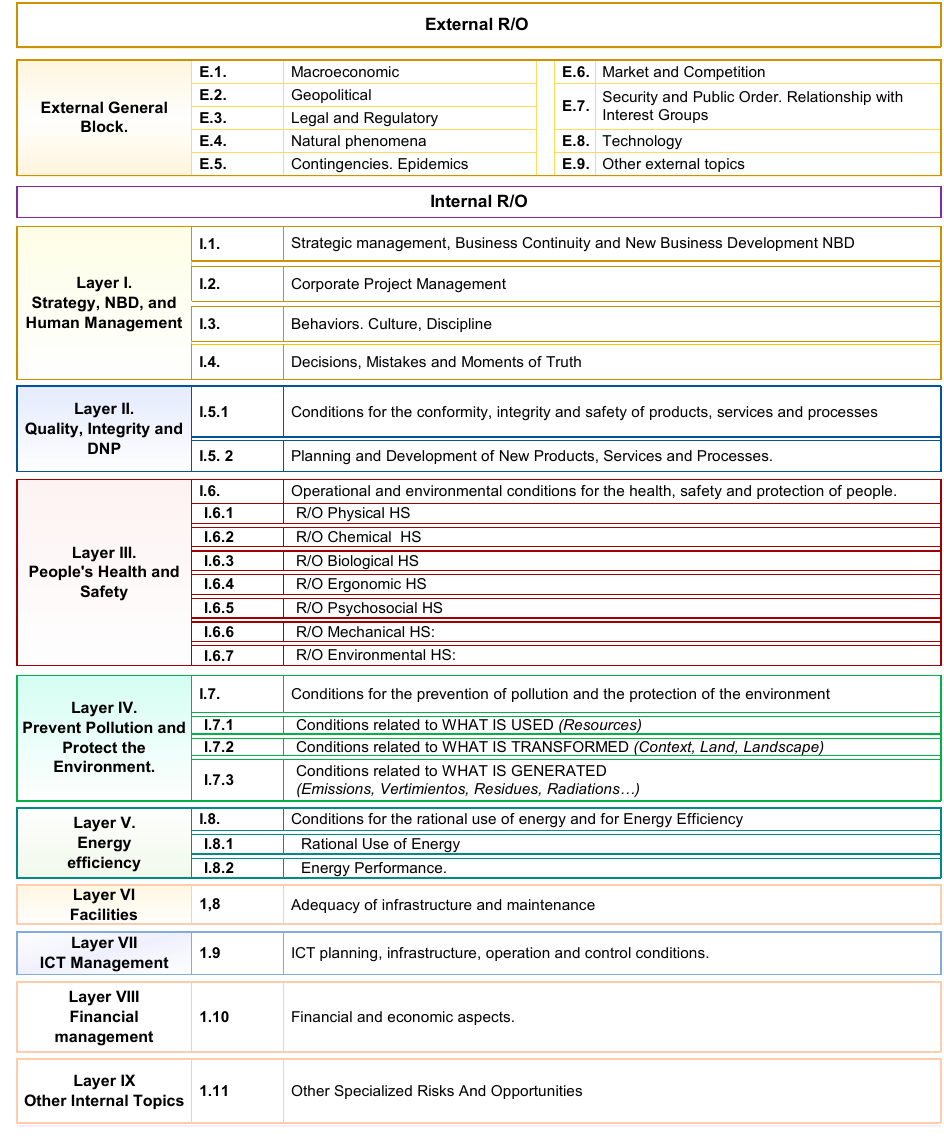
Figure 6. Classification matrix of topics related to the R/O of CMS QHSE3+ [25–30,91].